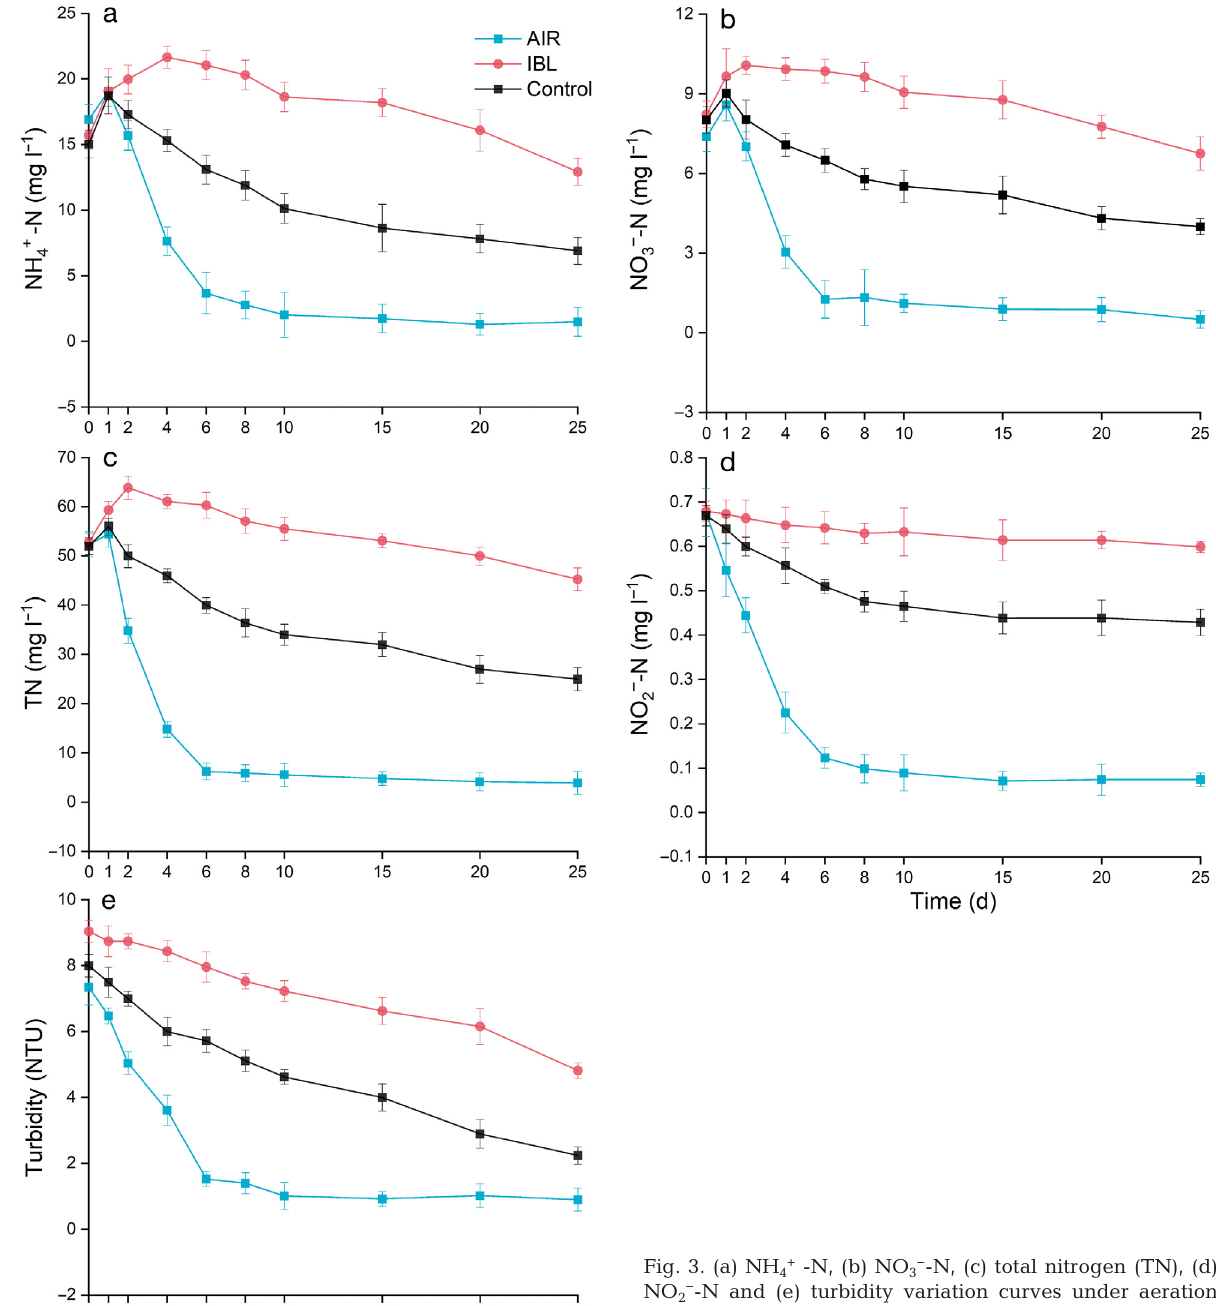
Fig. 3. (a) NH 4+ -N, (b) NO 3− -N, (c) total nitrogen (TN), (d) NO 2− -N and (e) turbidity variation curves under aeration (AIR), inactivated bacteria liquid (IBL) and Control treat- ments. Vertical bars represent ±SD of the means (n =